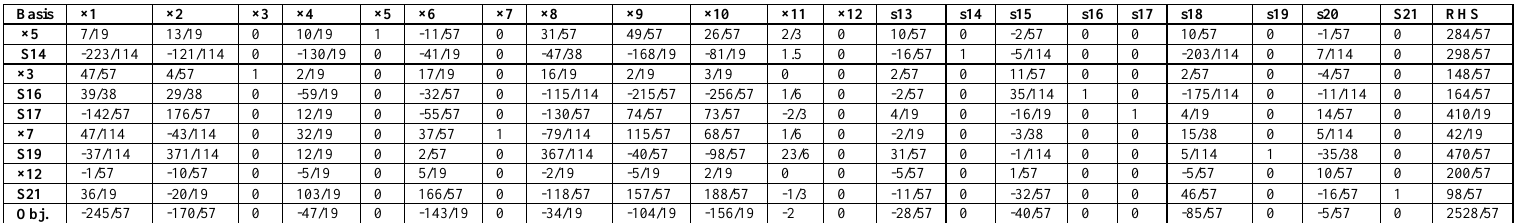
Table 4. Final table of the Simplex